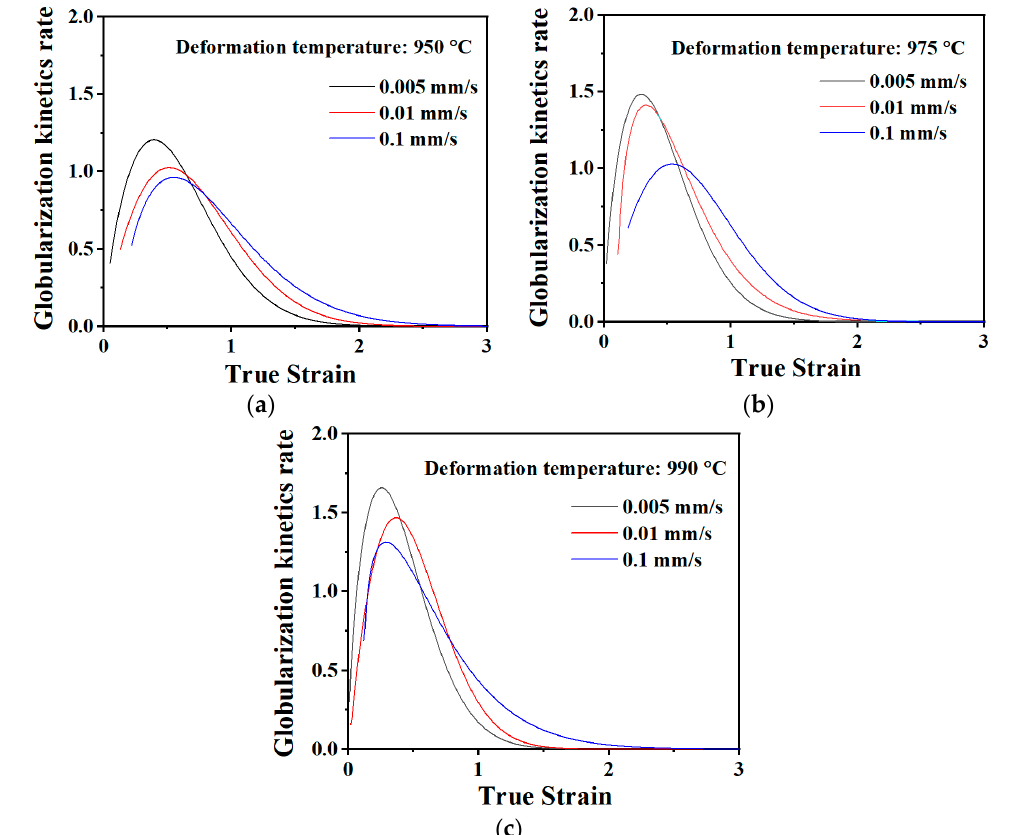
Figure 7. Globularization kinetics rate versus true strain curves under: ( a ) 950 °C; ( b ) 975 °C; and ( c ) 990